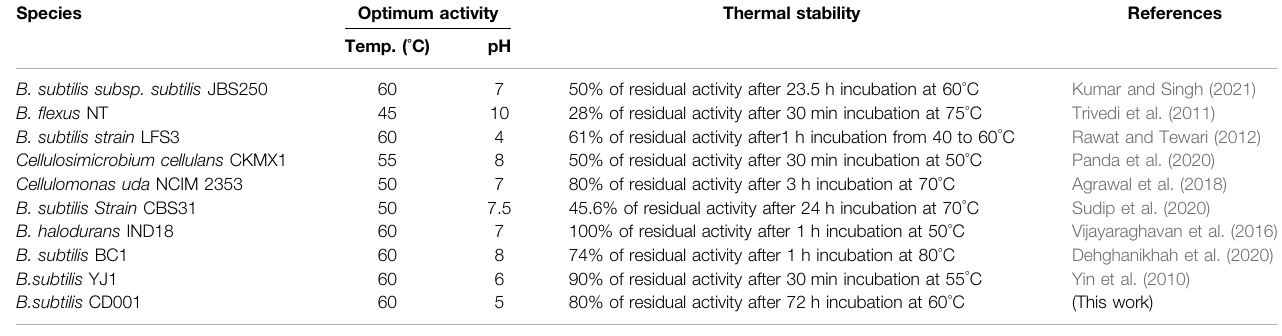
TABLE 2 | Comparison of the properties of cellulase from B. subtilis CD001 with those of cellulases reported from other bacterial strains. Species